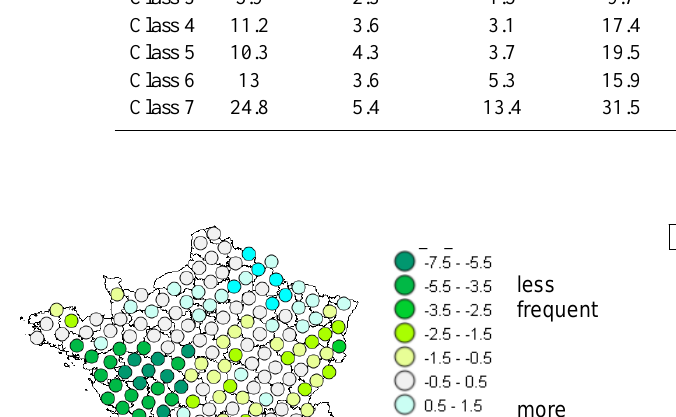
more frequent Figure 4. Risks of wheat shrivelling, using the MFA method to define zones. Left, definition of zones with present climatic data. Right, application to the future of the criteria defined in the present (distant A2 scenario).